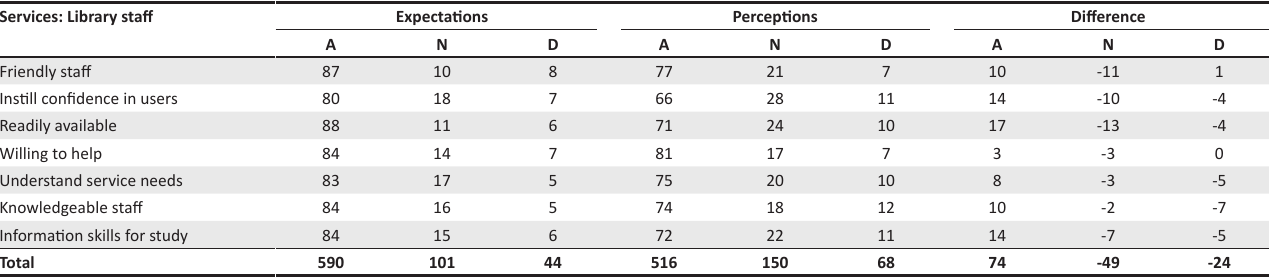
TABLE 4: Staff services. Services: Library